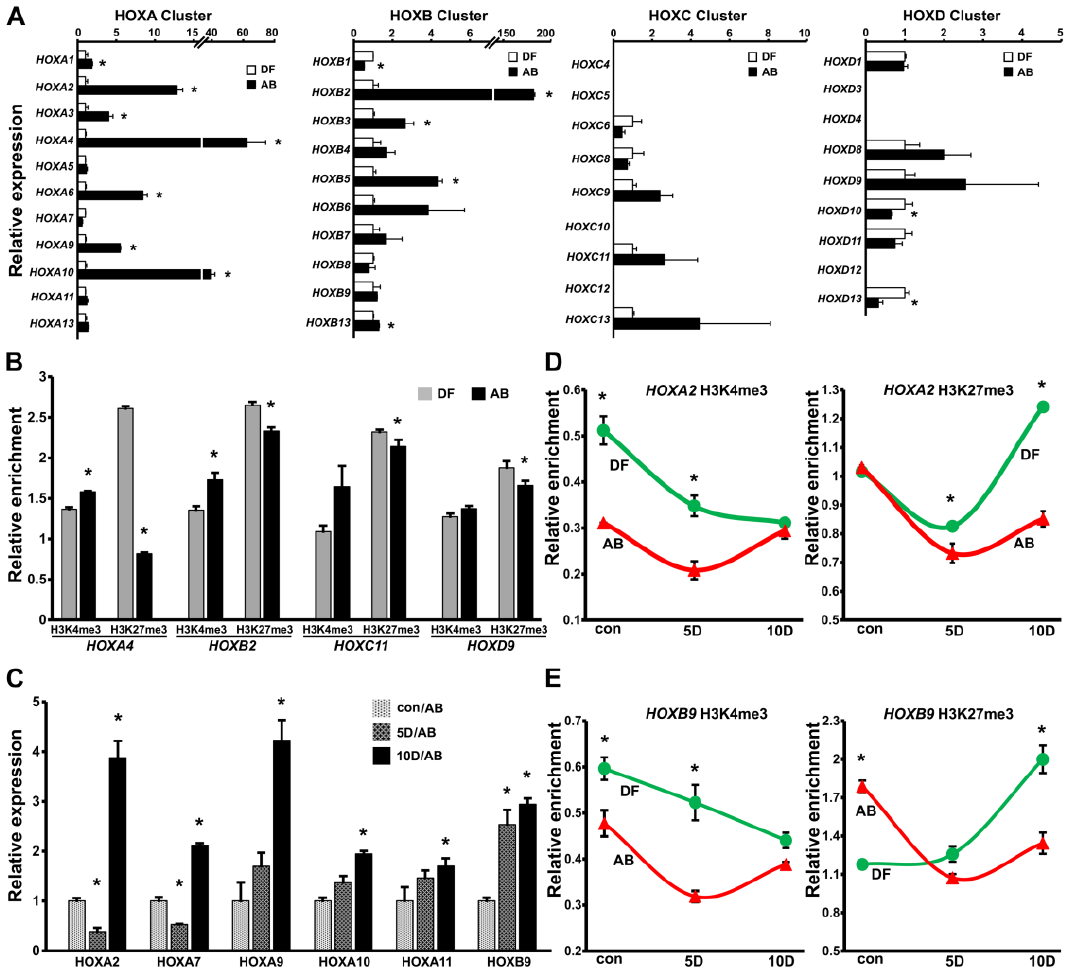
Figure 3. Higher HOX gene expression in AB cells when compared to DF progenitors. ( A ) Quantitative PCR analyses of HOX gene expression in human DF and AB progenitors. Transcript levels in AB cells were compared against DF cells and graphed as fold difference in expression levels. Expression data were obtained from biological replicates, n = 7. ( B ) Representative ChIP analysis for H3K4me3 and H3K27me3 enrichment in DF and AB progenitors at HOXA4 , HOXB2 , HOXC11 , and HOXD9 promoter regions. Histone modification enrichment values were normalized against corresponding inputs for each promoter primer pair after subtracting the background enrichment values. Enrichment data in AB cells were compared against DF cells. Data are from biological replicates, n = 5. ( C ) Comparison of select HOX gene expression levels as determined by quantitative PCR in control AB cells (con/AB) and in AB cells after 5 days (5D/AB) or 10 days (10D/AB) of in vitro mineralization induction. Expression levels at the 5 day and 10 day time point were compared individually to the con time point, n = 6. ( D , E ) Visual comparison of H3K4me3 and H3K27me3 enrichment dynamics at HOXA2 and HOXB9 promoters between DF and AB progenitors after 5 (5D) and 10 days (10D) of in vitro mineralization induction. Non-induced cells (con) were used to determine baseline levels of histone modification enrichment. Background enrichment values were subtracted in each case from corresponding histone enrichment values, n = 5. Elevated HOX gene expression was accompanied by a reduction in H3K27me3 enrichment over the 10-day induction period in AB cells. All assays were performed with early passage DF and AB progenitors (passage 3–4). Expression and ChIP data are presented as the mean ± standard deviation of the mean and considered as statistically significant (*) at p <